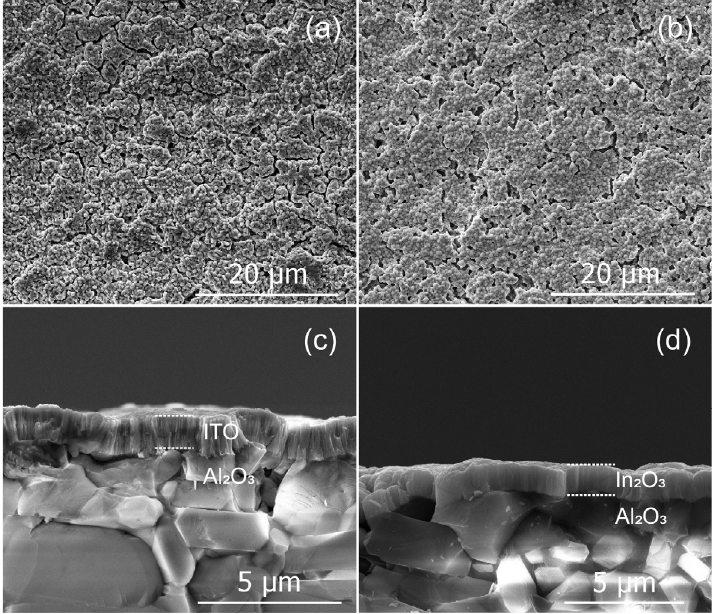
Figure 5. Surface morphology and cross-section of ITO film and In 2 O 3 film: ( a ) ITO surface image; ( b ) In 2 O 3 surface image; ( c ) ITO cross-section; ( d ) In 2 O 3 cross-section.